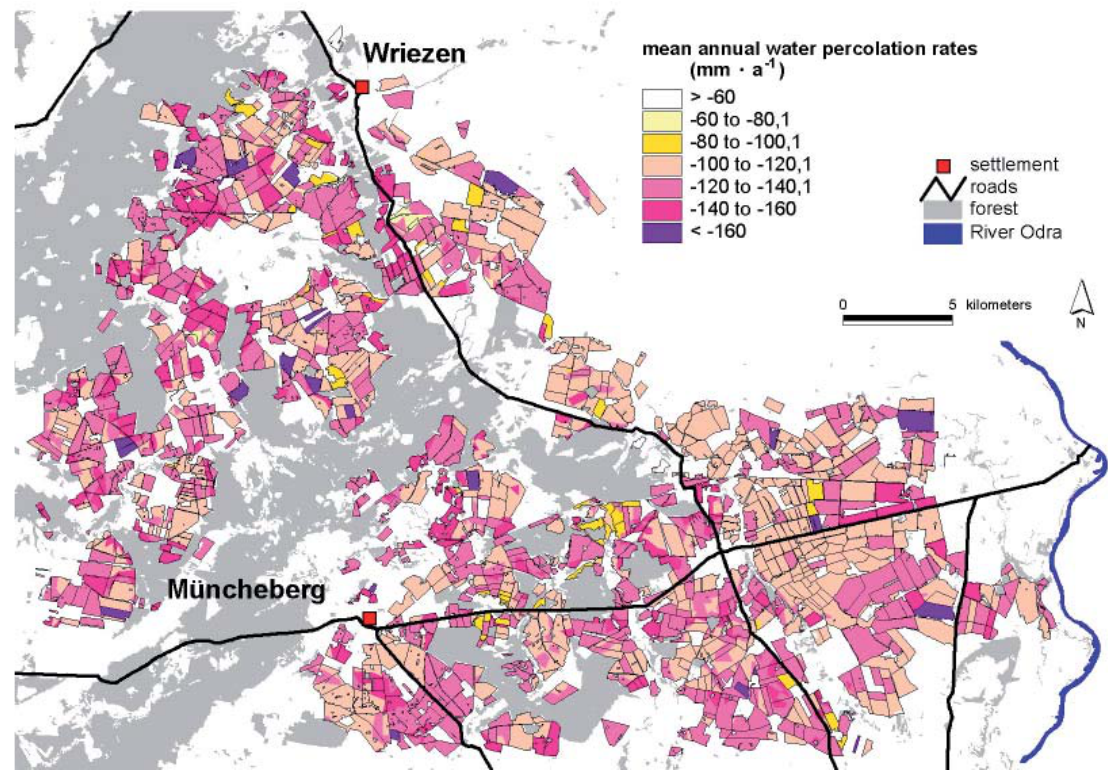
Figure 10. Difference between mean annual water percolation rates of Scenario 2050 and Initial Situati- on